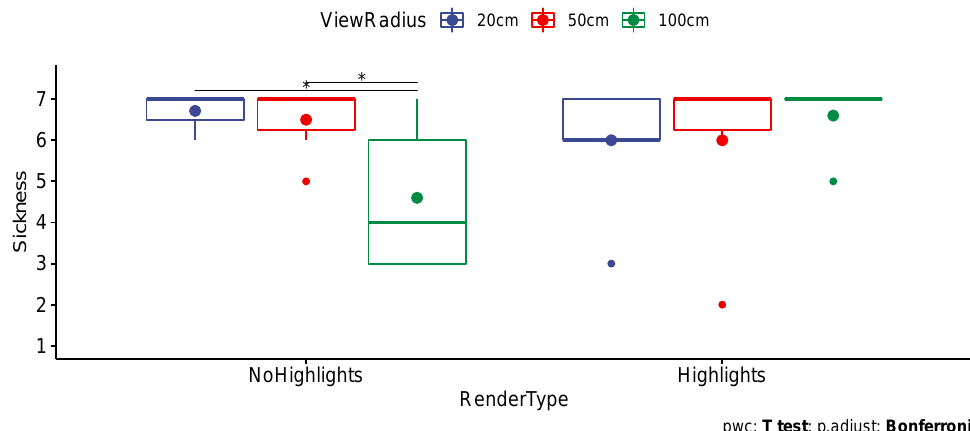
Figure 9. Perceived constraint during motion (higher is more free to move around) was shown to significantly differ based on viewing radius in the “Museum” scene.